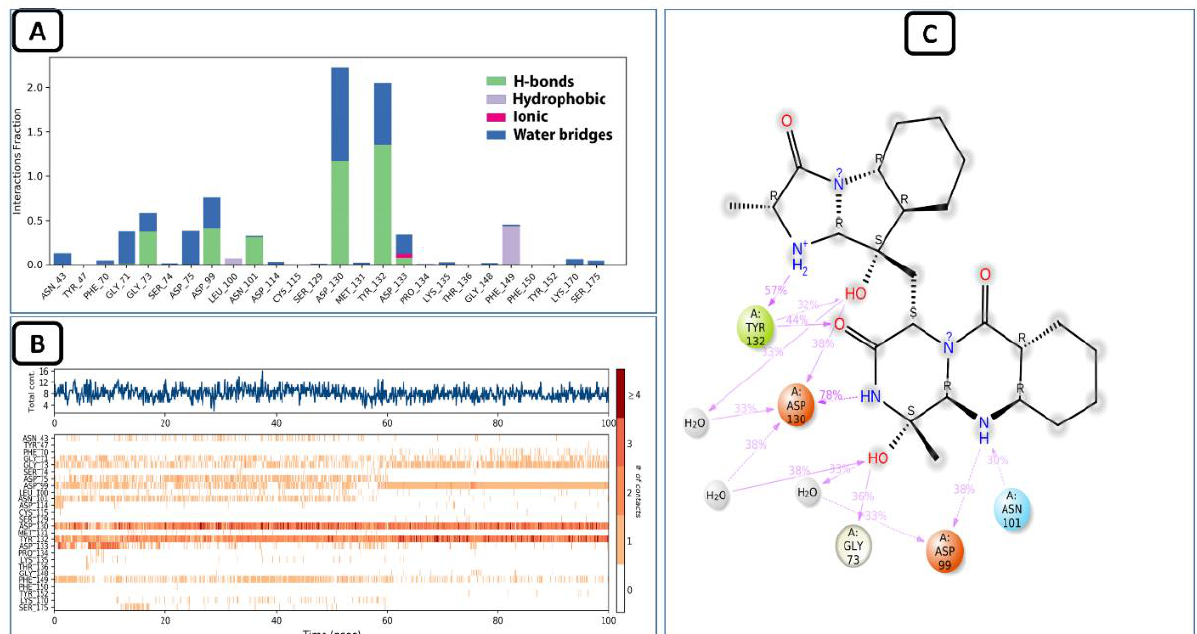
Figure 9. ( A ) Shows the protein-ligand interaction types, ( B ) shows the intensity of interactions, and ( C ) shows individual residues engaged by this ligand during the 100 ns